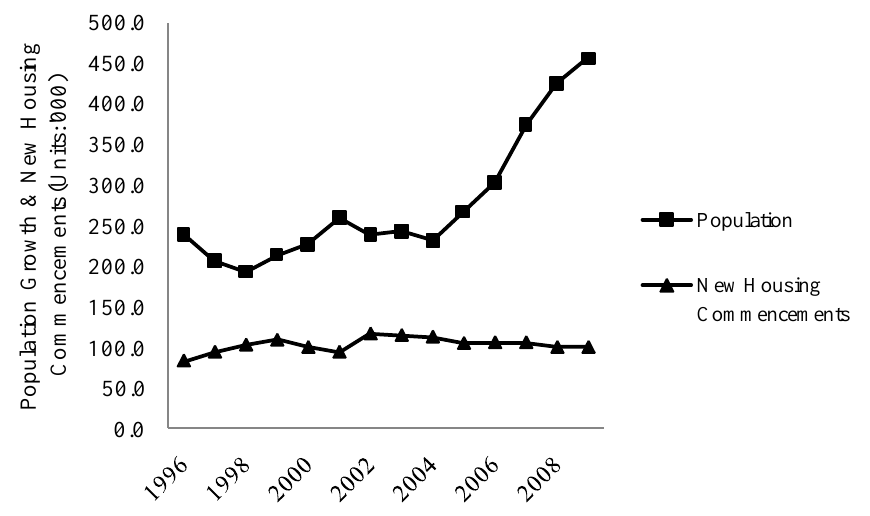
Figure 1 Population growth and new housing commencements in Australia (Source: ABS, 2010a)